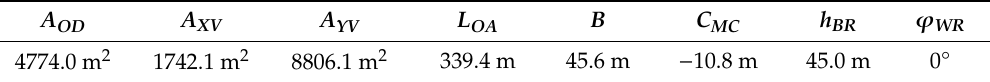
Table 7. Parameters for calculating the Fujiwara formula.